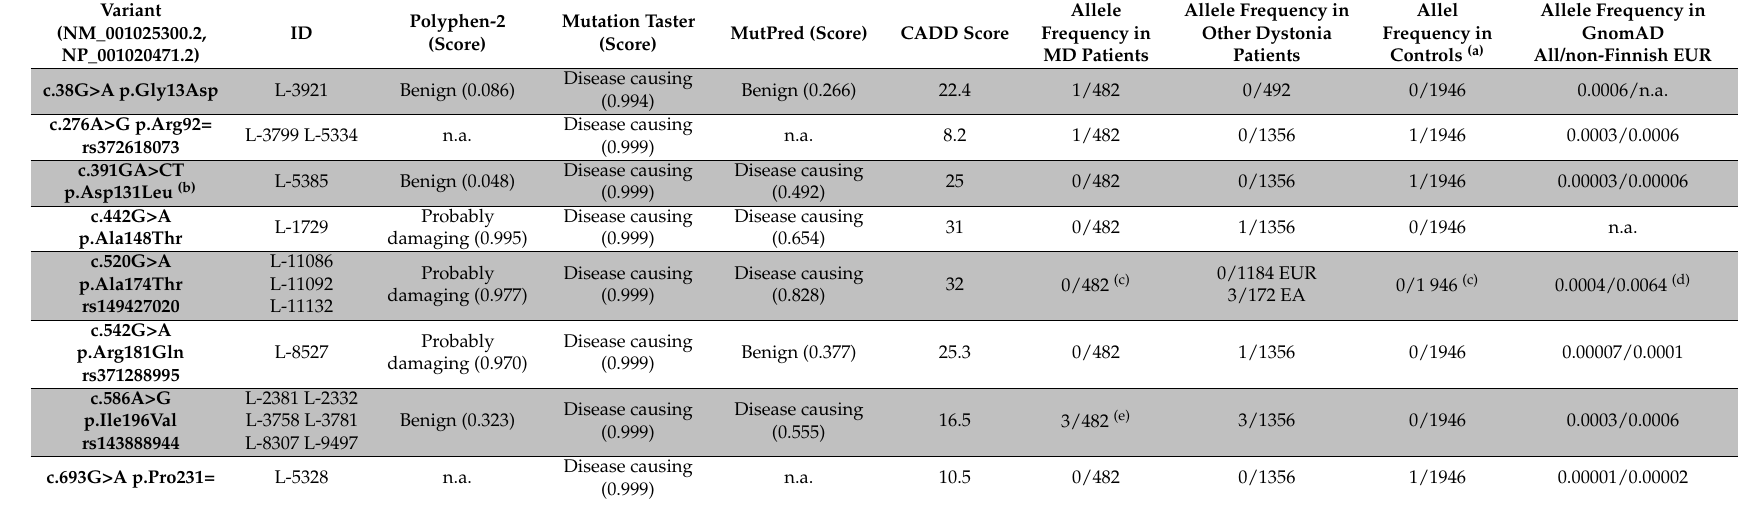
Table 2. Detected variants in RAB12 in musician´s dystonia and other dystonia patients as well as in the control